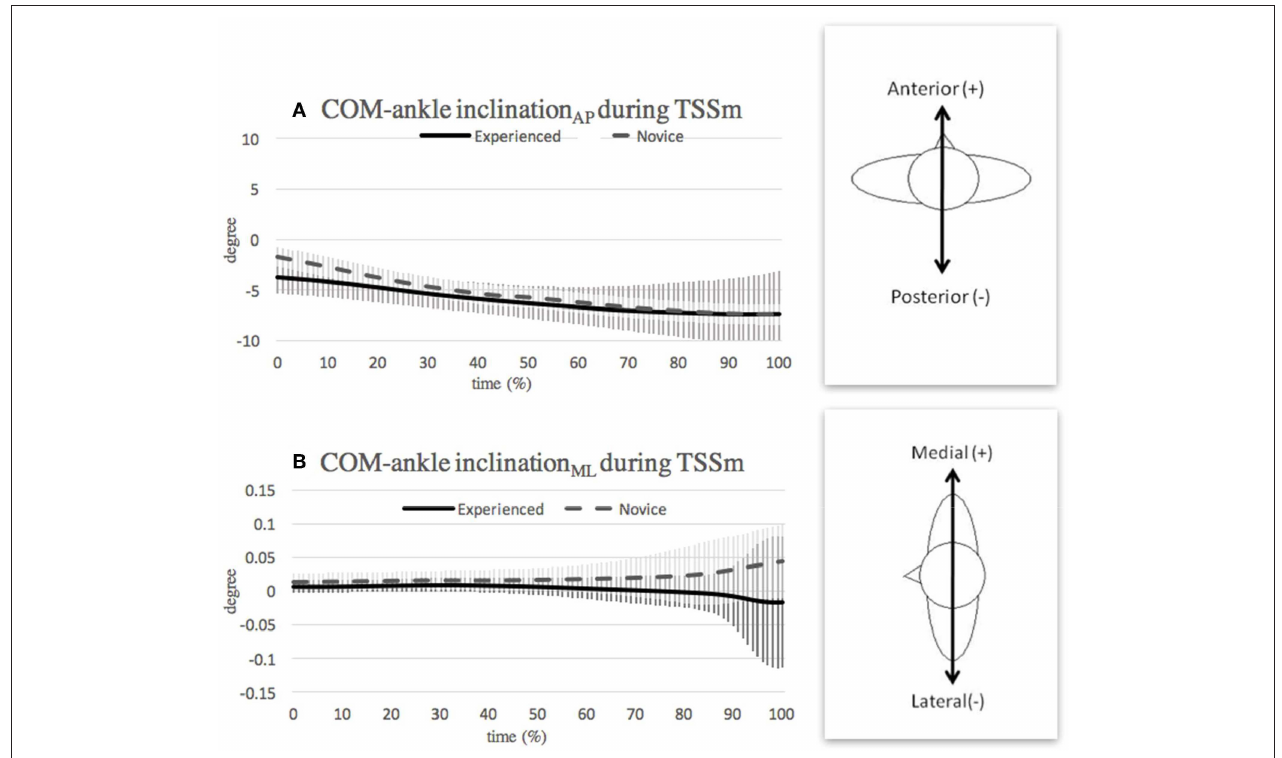
FIGURE 6 | Mean and SD of COM-ankle inclination angle in (A) anterior-posterior direction and (B) medial-lateral direction during turning with single-leg support in mid-swing (TSSm) phase. Note that the curves show the average value obtained over the three highest-scoring trials of each individual in the respective group.